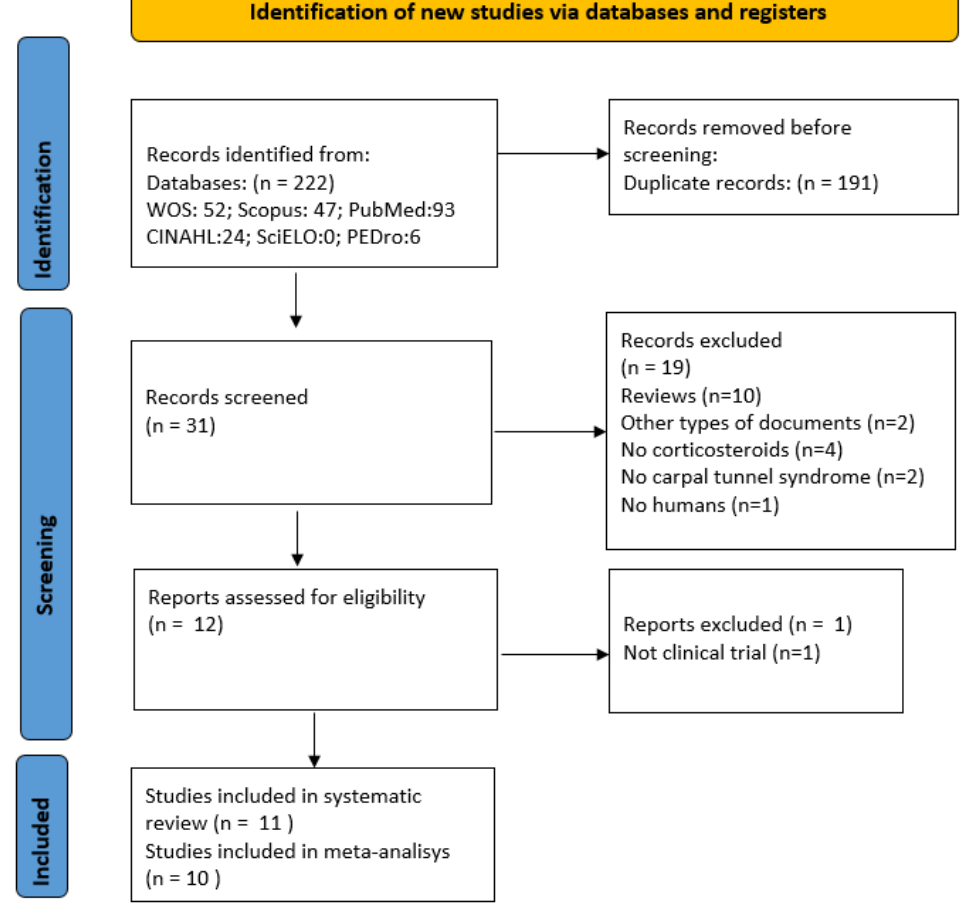
Figure 1. Flowchart of the studies selection process.